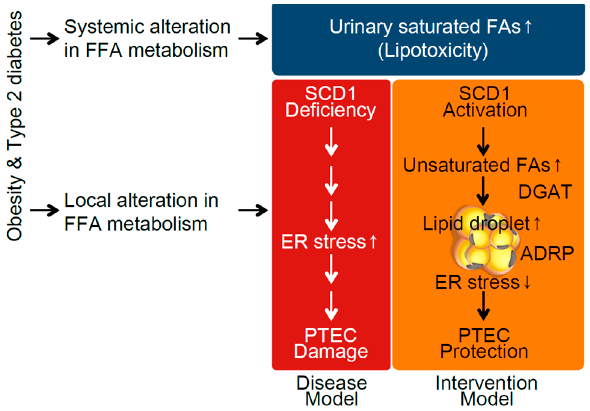
Figure 6. Schema showing the renoprotective mechanism of SCD1 against saturated fatty acid (SFA)-bound albumin-induced proximal tubular epithelial cell (PTEC) damage in type 2 diabetic nephropathy. Systemic alteration in FFA metabolism increases urinary SFA-related lipotoxicity. Furthermore, diabetic conditions alter intrarenal FA metabolism, characterized by SCD1 deficiency, enhancing ER stress-related PTEC damage. SCD1 activation may ameliorate SFA-induced PTEC damage via enhancing desaturation and subsequent lipid droplet formation.